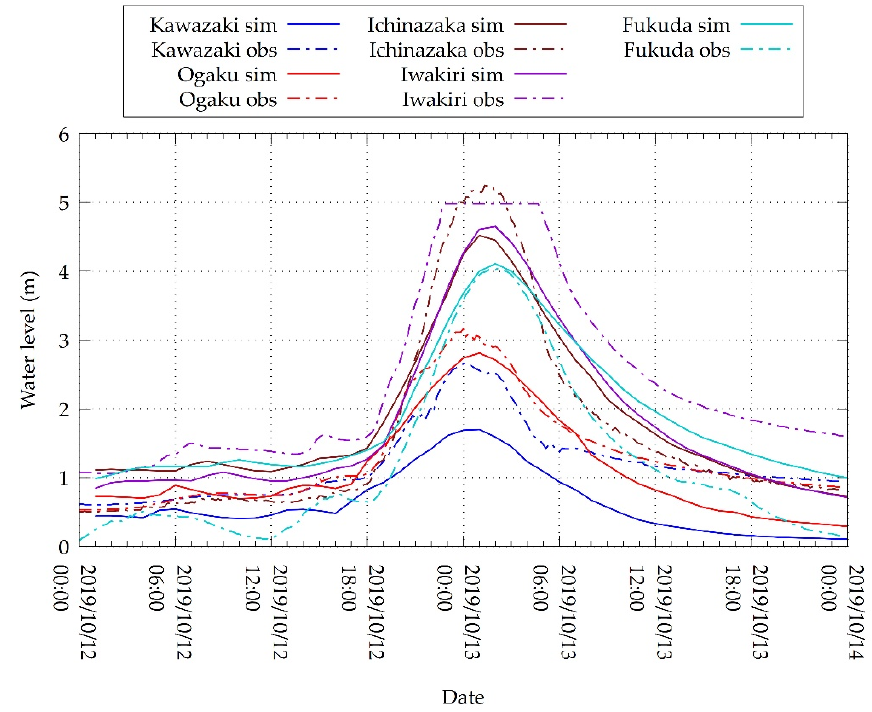
Figure 8. Comparisons between the RRI simulated and observed water levels in the 5 gauge sta- tions.